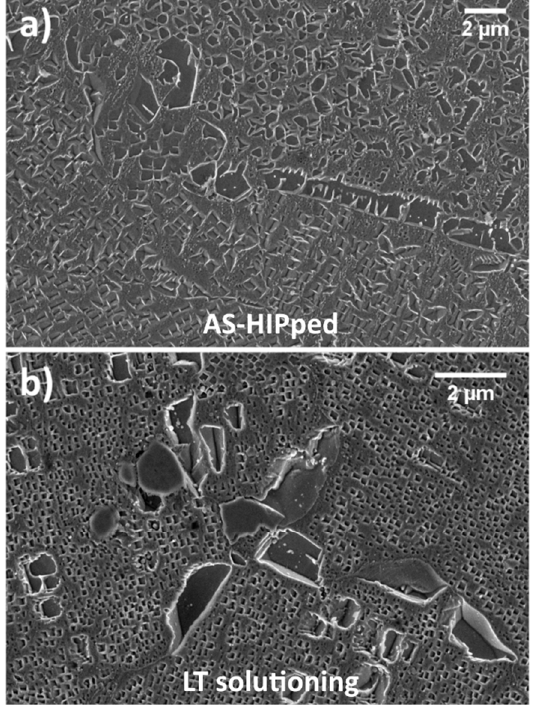
Figure 1. Astroloy in the as-HIPped (hot isostatic pressing) condition a ); after sub-solvus solutioning b ); after super-solvus solutioning c ). This step of the heat treatment was performed into a TAV MINIJET HP S/N 235 horizontal vacuum furnace (TAV, Caravaggio, Bergamo, Italy) where pressure was maintained at 10 − 2 mbar. These treatment conditions are summarized in Table 2. After these treatments, ɣ ’ amount was assessed to be 44% and 35% in volume for LT and HT samples respectively as also shown in [8]. The major difference observed between the two solutioning conditions is the achievement either of a partial (LT) or an almost complete (HT) dissolution of primary γ ’ at GBs. Therefore, the metallurgical state of LT and HT samples before aging steps exhibits a bimodal size distribution and a uniform size distribution of γ ’, respectively. Table 2. List of solutioning pre-treatment. Sample Name Solutioning Temperature [°C] Cooling Rate after Solutioning